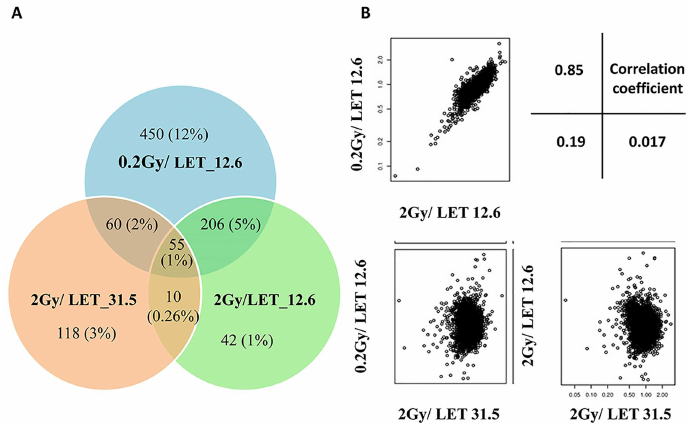
Fig 1. Proteins differentially expressed in cells exposed to 0.2 Gy low and 2 Gy high doses of carbon ions with different LET values. (A) Venn diagramshowingdistinct and overlappingproteins differentially regulated among these three groups of carbon ion-irradiatedcells. (B) Correlation analysis of protein expression changes among the three groups. The corresponding correlationcoefficients are shown in the top right corner.